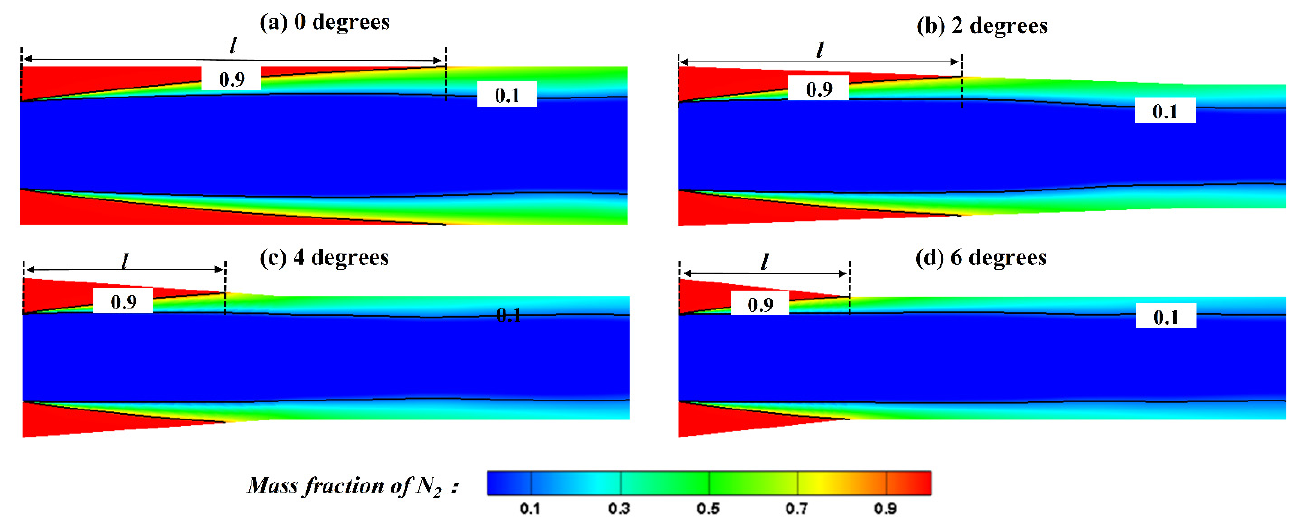
Figure 9. Mass fraction cloud map of N2 with different mixing chamber contraction angles.